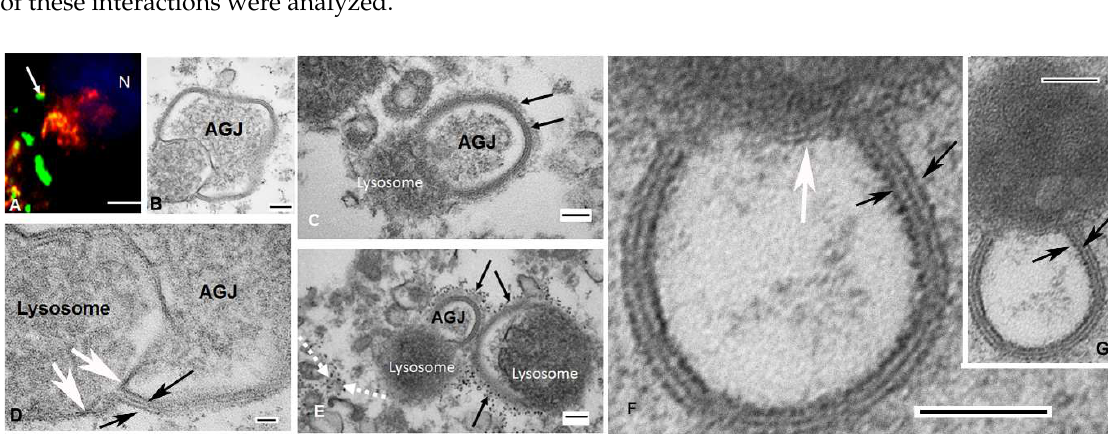
Figure 3. Localization of annular gap junction vesicles and lysosomes. ( A ) Immunocytochemical localization of endogenous Cx43 (green) and lysosomes detected with LAMP1 (red) demonstrates the colocalization (yellow) of an annular gap junction vesicle and lysosome (arrow). ( B – G ) The intimate contact between annular gap junction (AGJ) and lysosomes, which are in various stages of degradation is shown. In B (and enlarged in D ) the outer membrane of the annular gap junction can be seen to be continuous with that of the lysosomal membrane (white arrows). Clathrin, identified by the bristle coat (arrows, C ) or quantum dot label (black arrows, E ), can be seen associated with annular gap junction vesicles that are fused with lysosomes. Typical clathrin-coated vesicles also can be seen decorated with clathrin Q dots (dashed white arrows in E ). F (enlarged from G ) and D (enlarged from B ) have been magnified to allow the annular gap junction pentalaminar membranes to be clearly seen (black arrows) and the change in this membrane at the annular/lysosomal junction to be appreciated (white arrows in F and D ) N = Nucleus; Scale Bars = ( A ): 10 µm, ( B , C , E – G ): 100 nm, ( D ): 20 nm.